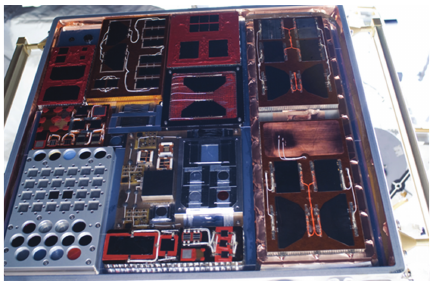
Figure 9: Sun looking face of the Passive Experiment Container (PEC) containing passive material samples and cells as flown on Materials International Space Station Experiment 7 (MISSE7). Solar cells can be denoted by the wires to attach to the measurement circuitry of the Forward Technology Solar Cell Experiment II (FTSCE II) (image courtesy of